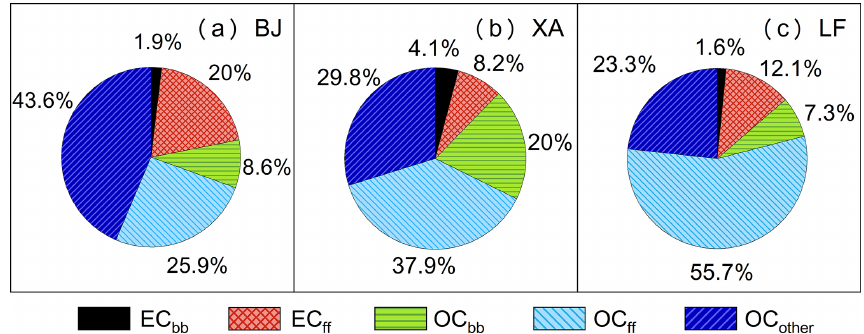
Figure 8. Percentage of elemental carbon from biomass burning (EC bb ) and fossil-fuel combustion (EC ff ) and percentage of organic carbon from biomass burning (OC bb ), fossil-fuel combustion (OC ff ), and other sources (OC other ) for the PM 2 . 5 samples in BJ, XA, and